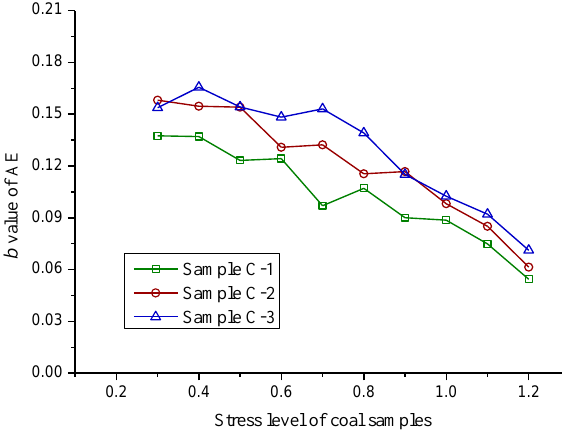
Figure 11. b value of the AE of coal samples under different mining paths.